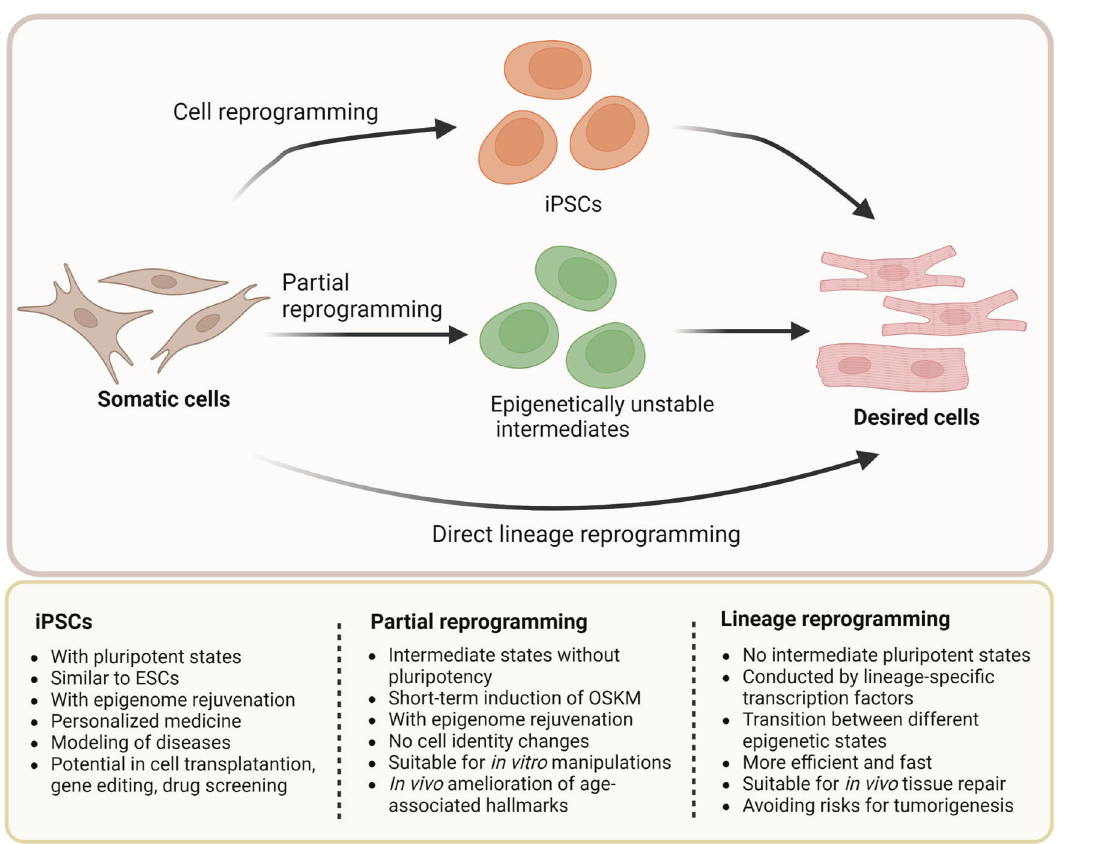
Fig. 5 Reprogramming approaches for rejuvenation. The iPSC-mediated cell reprogramming is a protocol that somatic cells are fi rst dedifferentiated into iPSC and then differentiated into the desired somatic cells. Partial reprogramming refers to a short exposure to Yamanaka factors only generates intermediates with high plasticity. Transforming somatic cells from one lineage to another without transitioning through intermediary pluripotent stages is known as direct lineage reprogramming. iPSCs induced pluripotent stem cells, ESCs embryonic stem cells; Oct3/4, Sox2, Klf4, c-Myc, OSKM. Created with